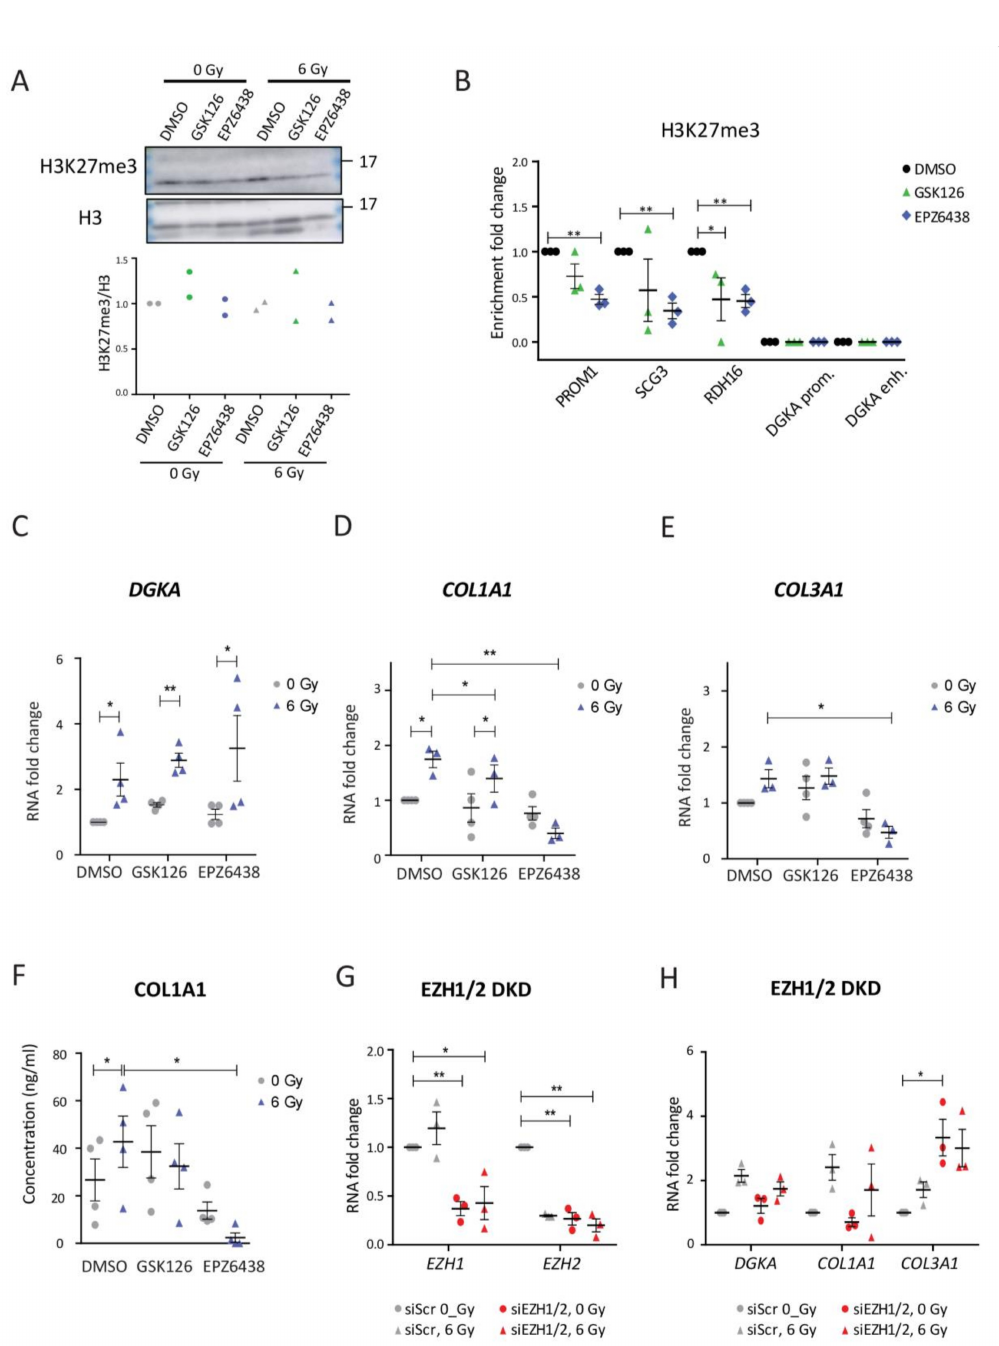
Figure 4. Treatment with EZH1/2 inhibitors did not affect radiation-induced DGKA expression and suppressed the induction of a pro-fibrotic response. ( A ) Nuclear H3K27me3 expression in BJ cells treated with EZH2 inhibitors. ( B ) Quantitative ACT-seq signals for H3K27me3 enrichment at the indicated loci in BJ cells. ( C – E ) Relative mRNA expression of DGKA ( C ), COL1A1 ( D ), and COL3A1 ( E ) in BJ cells. For ( A – E ), cells were pre-treated with DMSO, GSK126 (5 µ M), or EPZ6438 (50 µ M) for 48 h, irradiated with 6 Gy, and harvested after an additional 48 h with concurrent drug treatment. ( F ) Secreted COL1A1 was measured by ELISA. Cells were pre-treated with DMSO, GSK126 (5 µ M), or EPZ6438 (50 µ M) for 48 h, irradiated with 6 Gy, and the conditioned medium was harvested after an additional 72 h with concurrent drug treatment. ( G , H ) Relative mRNA expression of EZH1 and EZH2 ( G ) as well as DGKA , COL1A1, and COL3A1 ( H ) in BJ cells after double-knockdown of (DKD) of EZH1 and EZH2. Cells were pre-treated with siRNAs directed against both enzymes for 48 h, irradiated with 6 Gy, and harvested 48 h later. Statistical data are presented as mean ± SEM from three ( B – G ) or four ( F ) biological replicates. Statistical significance (* p < 0.05 and ** p < 0.01) was determined by one-tailed Student’s t